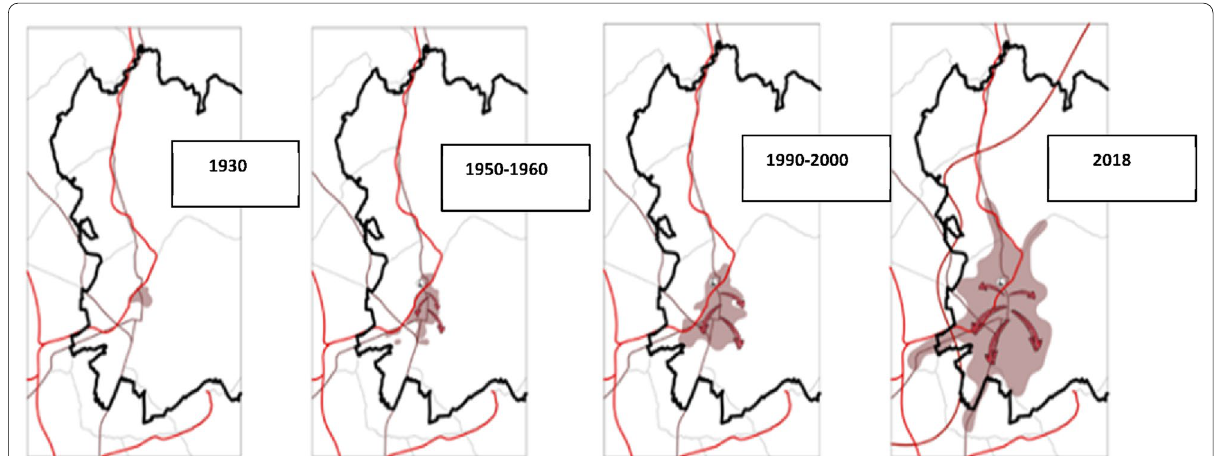
Fig. 1 Prishtina urban development during the years (author: G.Kuleta)